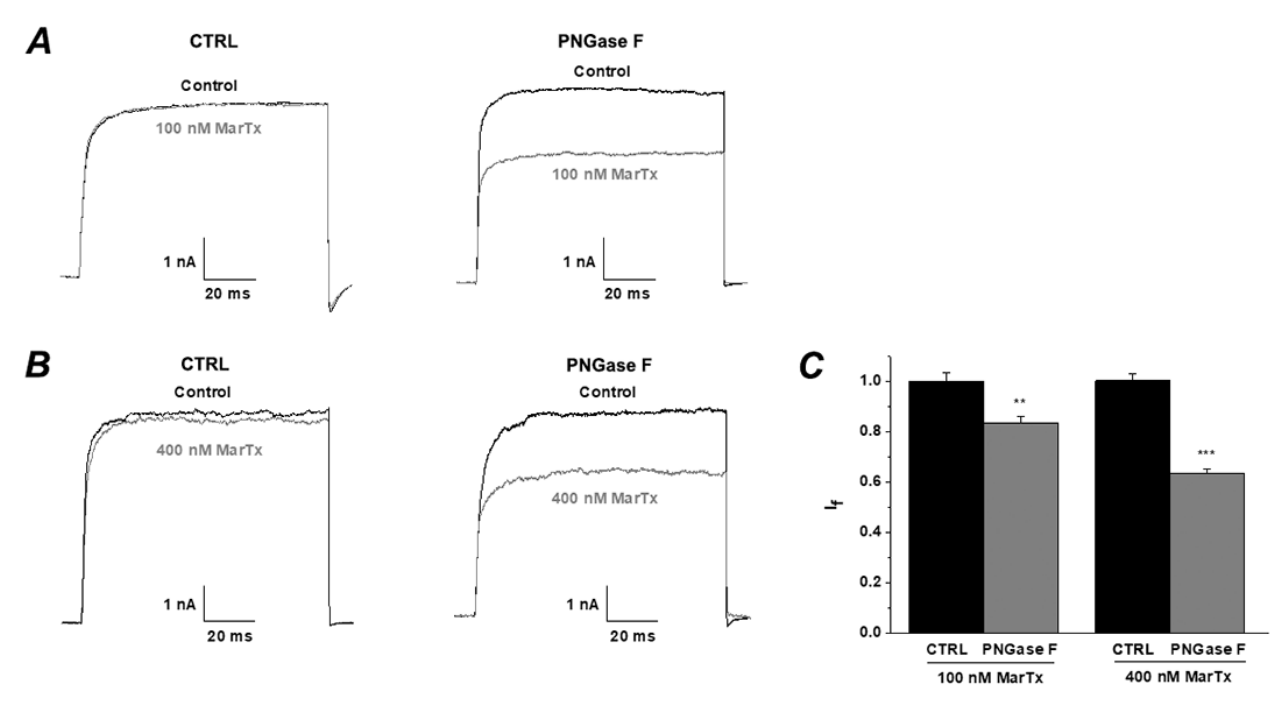
Figure 7. The application of PNGase F enhances the inhibitory effects of MarTX on BK ( α + β 1) channel. (A-B) Whole-cell current traces from deglycosylation BK channels before and after the application of MarTX (A) 100 nM and (B) 400 nM without treatment (left, CTRL) or pretreatment with PNGase F (right, PNGase F). The holding voltage was -80 mV and the currents were elicited by a pulse of +100 mV. (C) Statistical analysis of the inhibitory ratios of MarTX on BK ( α + β 1) channels without treatment (left, CTRL) or pretreatment with PNGase